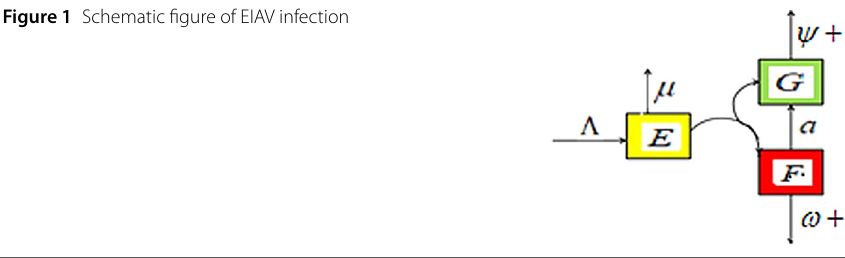
Figure 1 Schematic figure of EIAV infection